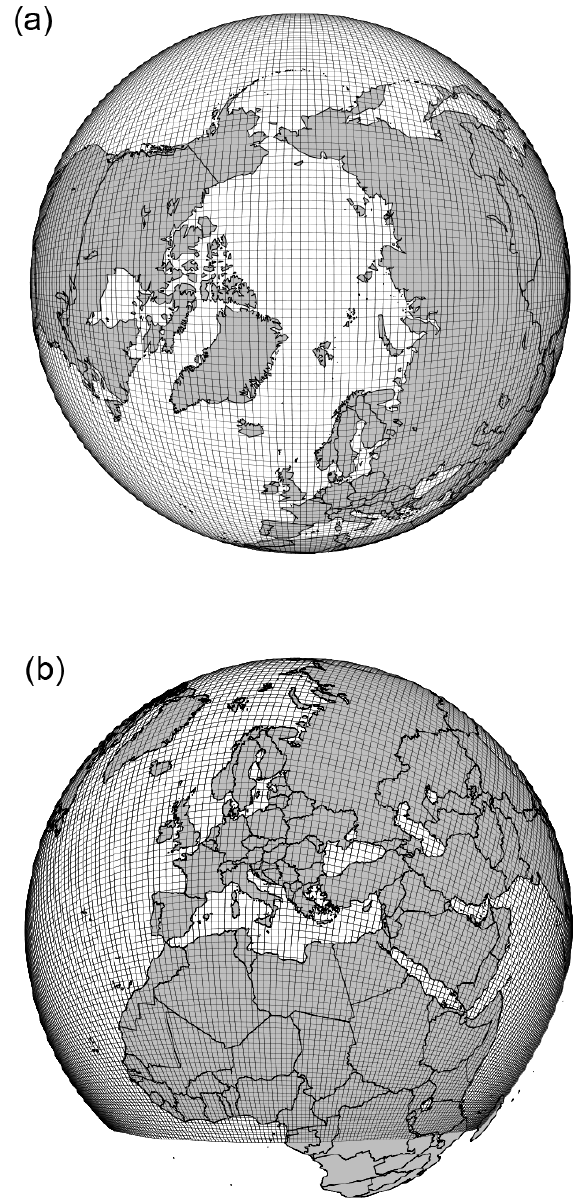
Figure 3. Model grid generated for the Northern Hemisphere with 180 × 180 points in polar stereographic projection, viewed from the top (upper panel) and from the side (lower